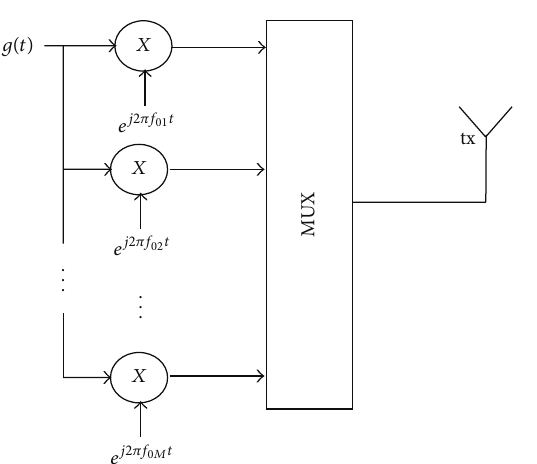
Figure 4: Block diagram of OFDM multiband radar system.